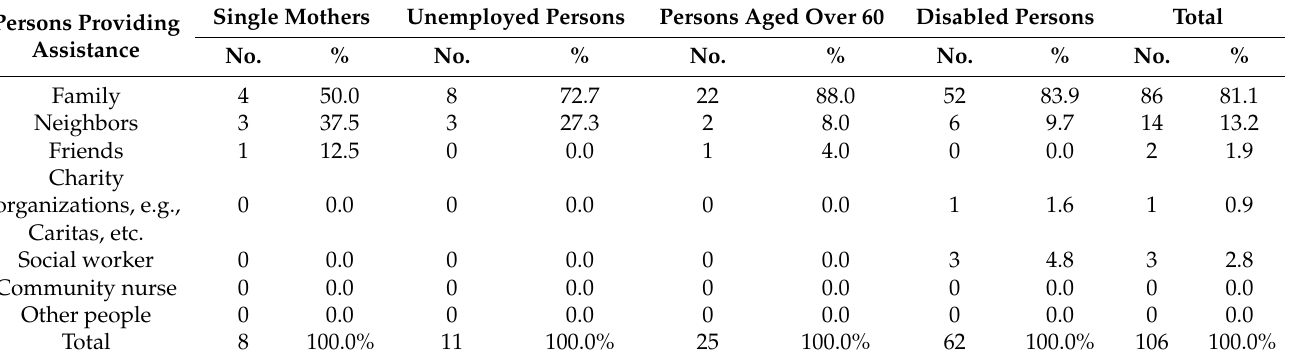
Table 7. Relying on the assistance of other persons by social status of the respondents ( n =